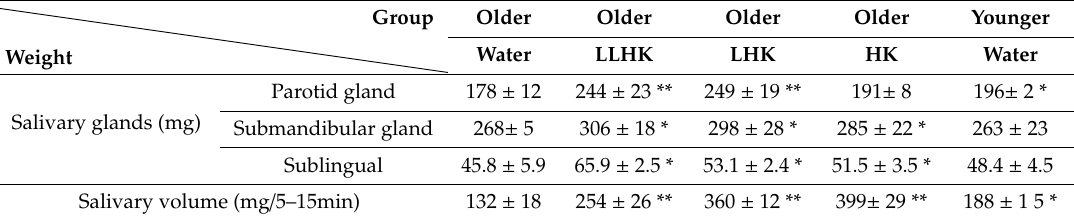
Table 2. Salivary gland weight and salivary volume in water-treated and peptide-treated groups.